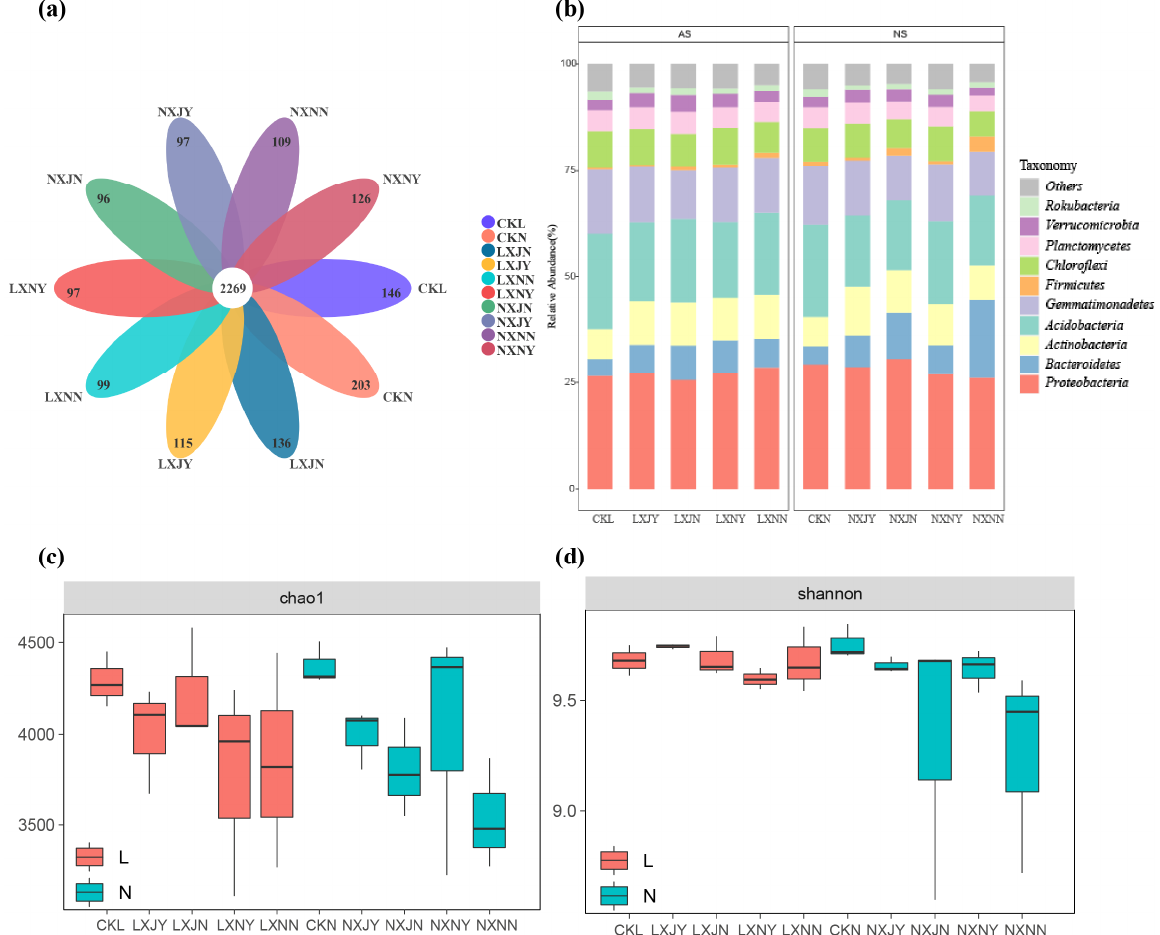
Figure 5. Effects of D74 agents and maize rotation on the α-diversity of sunflower rhizosphere bacterial community. Include OTUs petal map ( a ), relative abundance of Top 10 in phylum level ( b ), AS: added O. cumana , NS: unadded O. cumana ), chao1 index ( c ), and shannon index ( d ).